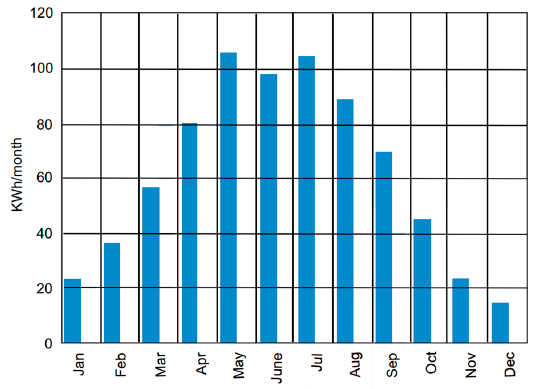
Figure 16. Typical monthly energy generation for a solar panel in the UK; adapted from [60].